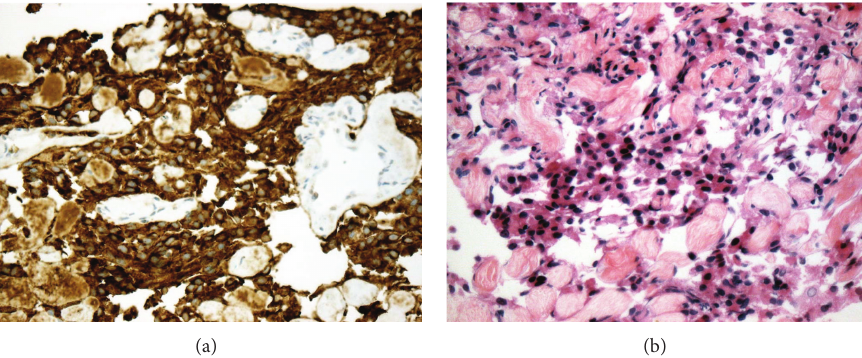
Figure 1: Low-grade neuroendocrine neoplasia of the pancreas. (a) Strong and diffuse expression of chromogranin A. (b) By immunohisto- chemistry.